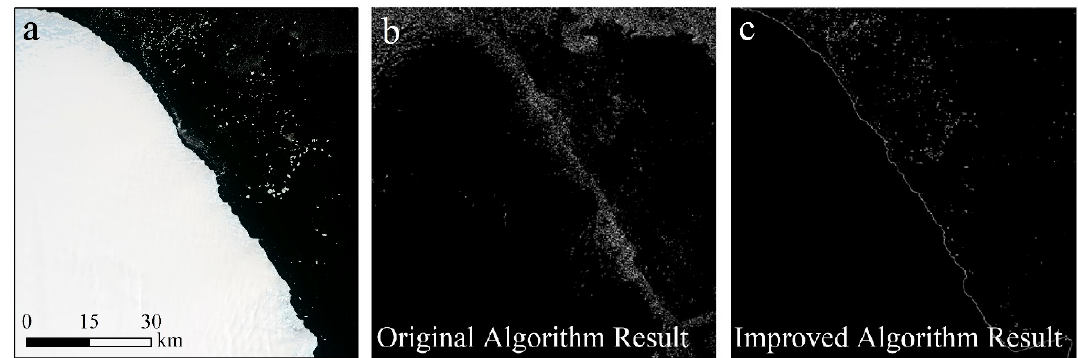
Figure 1. Comparison between edge points from using a fixed pair threshold—for maximum and minimum ( b ), and an adaptive pair of thresholds (in the improved algorithm) ( c ). The corresponding Landsat-7 image shown in ( a ) was acquired on 25 January 2017. The improved edge detector yields much less noise and better continuity in the extracted coastline.